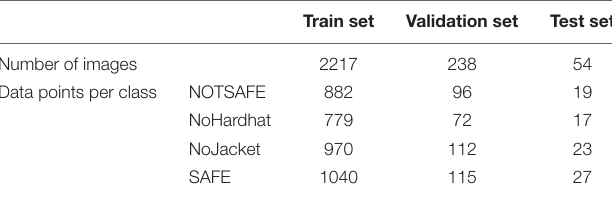
TABLE 1 | Data point distribution among train-validation-test